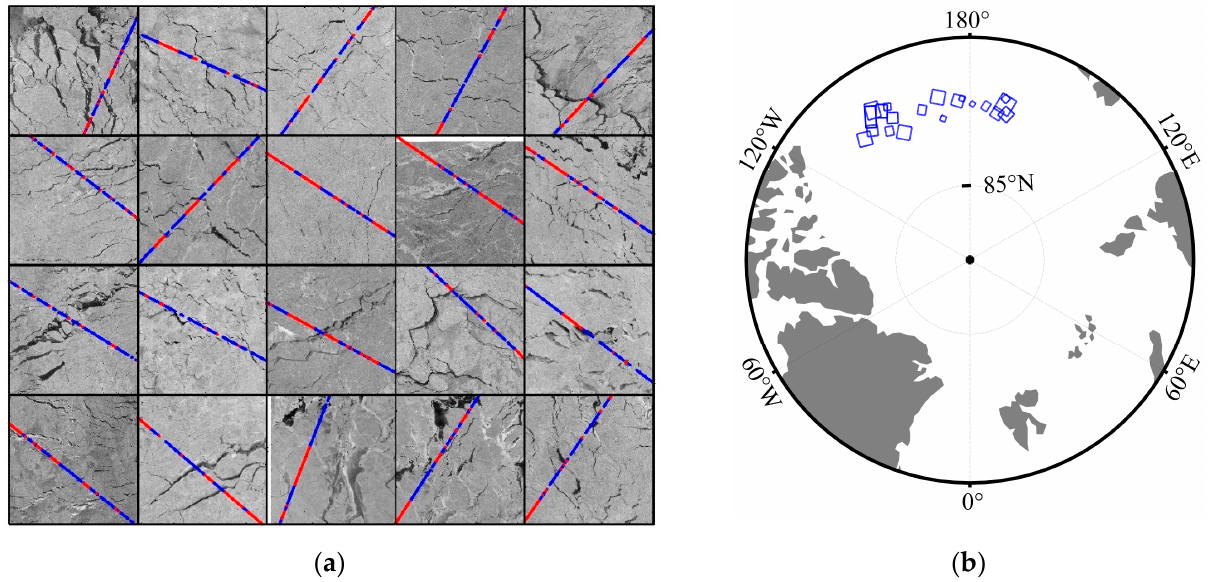
Figure 2. Differences in track of HY-2B radar altimeter data for different trackers in sea ice and ice lead: ( a ) the blue points are OCOG. The red points are SMLE. The images are Sentinel-1 SAR image. ( b ) The track of Sentinel-1 SAR image edge in Figure 2a.